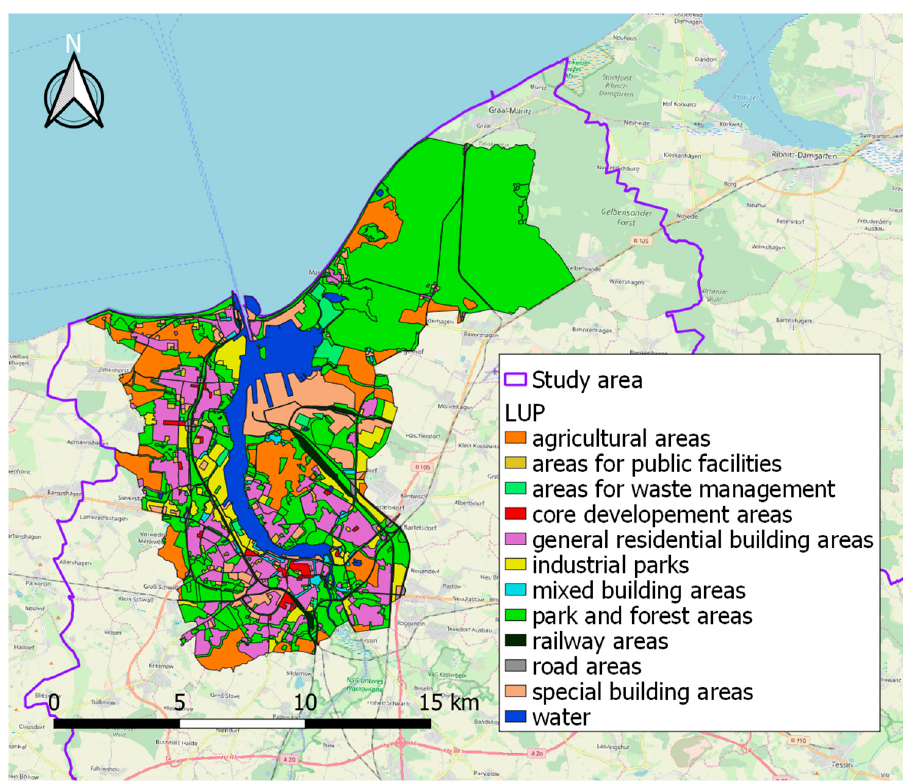
Figure A1. Land-use plan (LUP) of the city of Rostock.